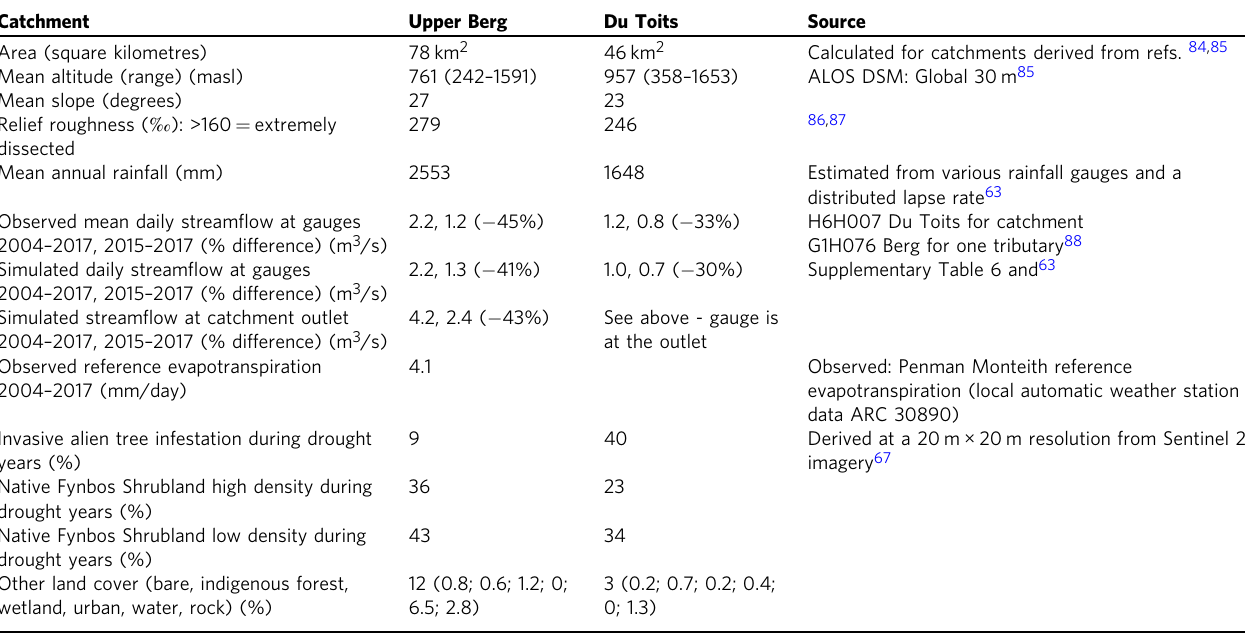
Table 2 Catchment